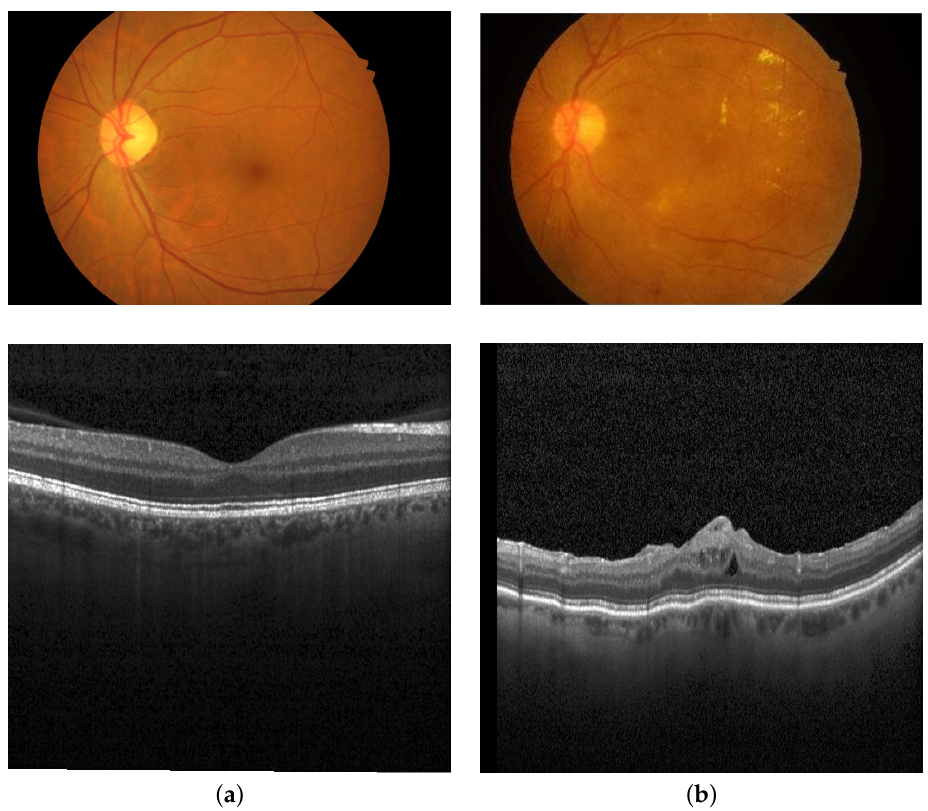
Figure 1. Sample retinal images: ( a ) Healthy; ( b ) DM-diseased. Upper row: fundus images from the IDRiD dataset. Lower row: OCT images from the OCT